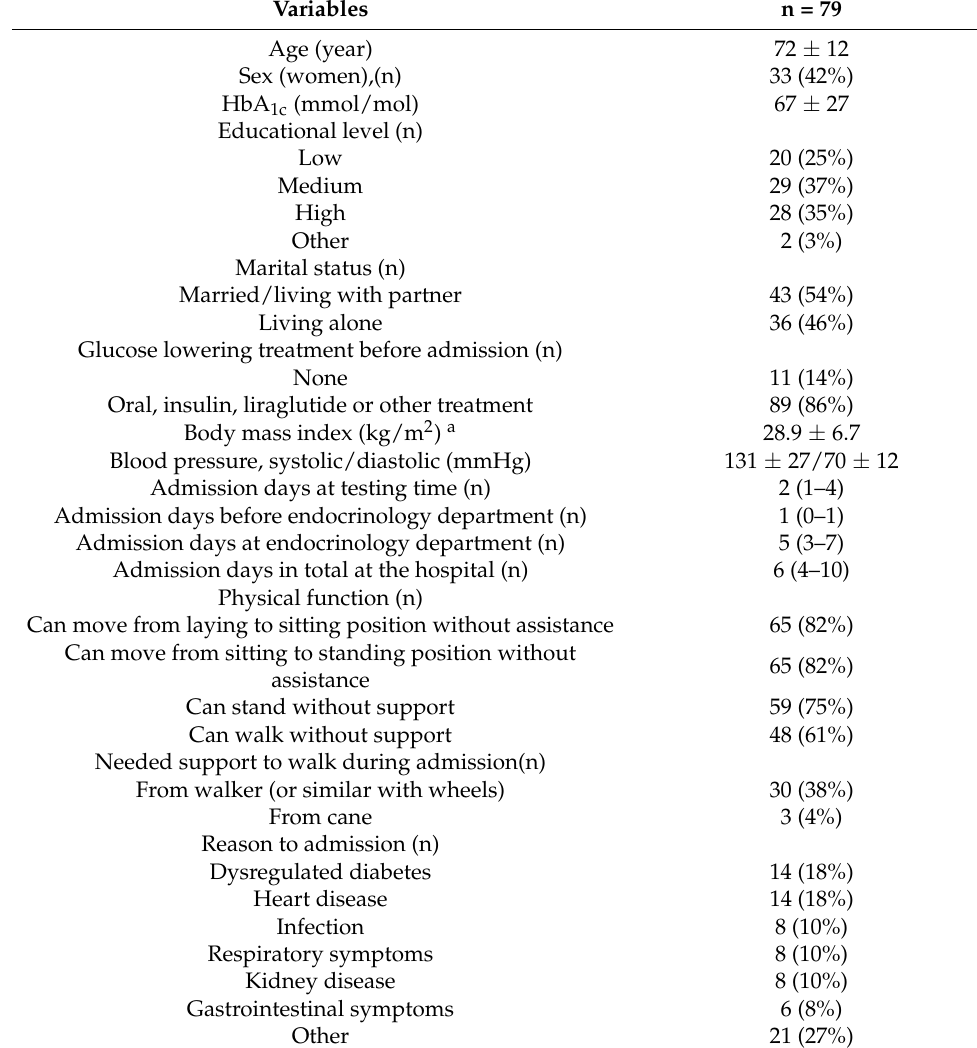
Table 1. Characteristics of the